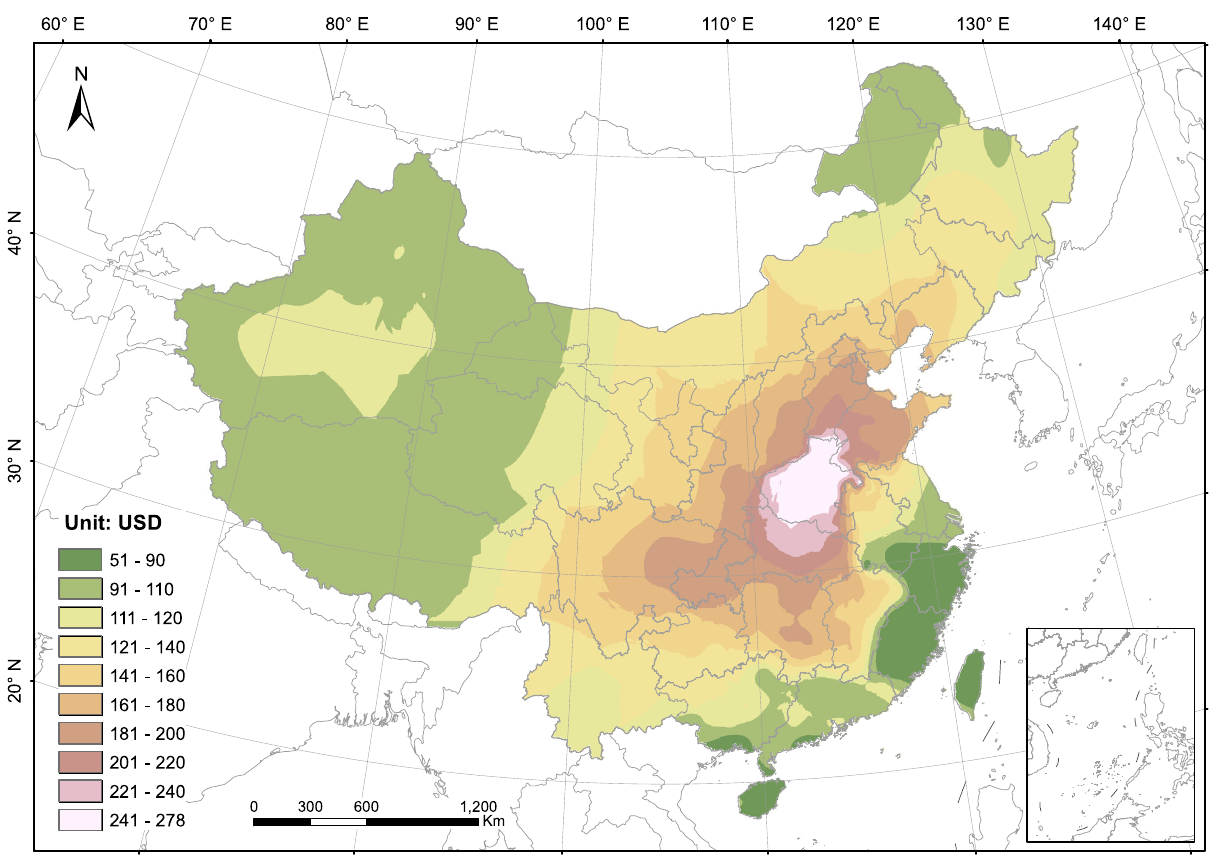
Fig. 1 Health co-bene fi ts of per ton CO 2 emission reduction from coal- fi red power plants in different locations. The unit is in U.S. dollar (USD). Higher values indicate that phasing out or retro fi tting existing plants, or prohibiting the construction of new plants in these areas, will achieve greater co-bene fi